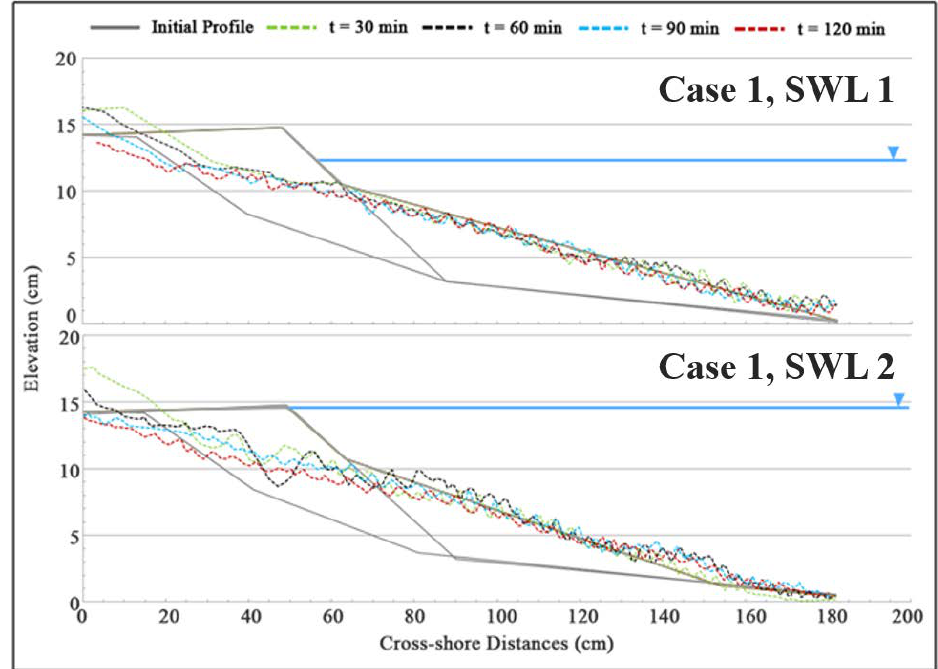
Figure 6. Case 1 with SWL 1 and SWL 2 profile evolution at t 1 , t 2 , t 3 , and t 4 .